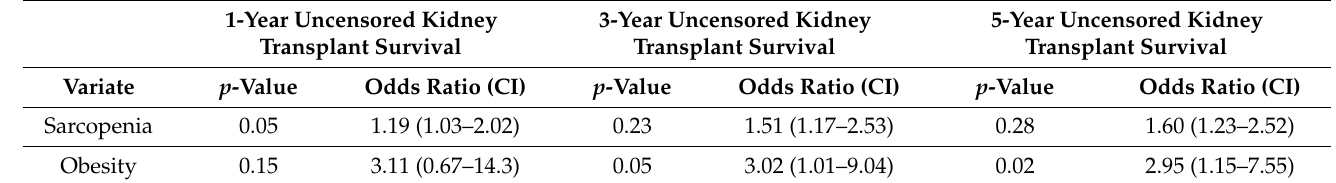
Table 8. Cox regression analysis of 1-year, 3-year and 5-year uncensored kidney survival with cutoff values for sarcopenia and obesity. CI = confidence